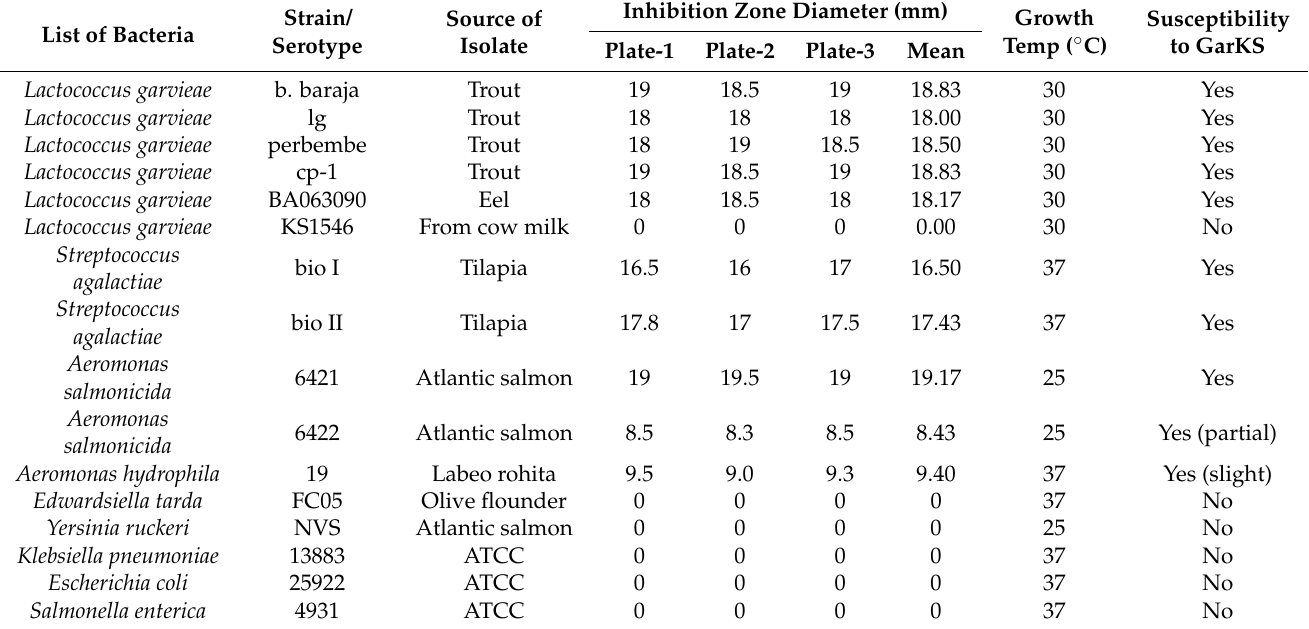
Table 1. Bacterial isolates used for bacteriocins inhibition